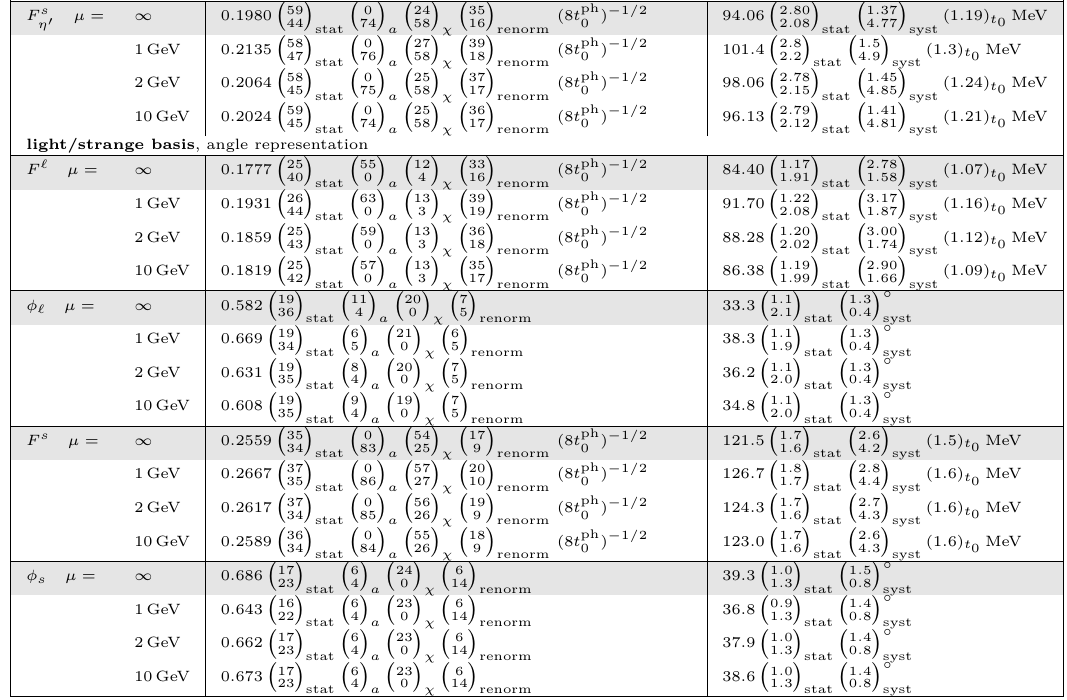
Table 25 (continued): Decay constants at various